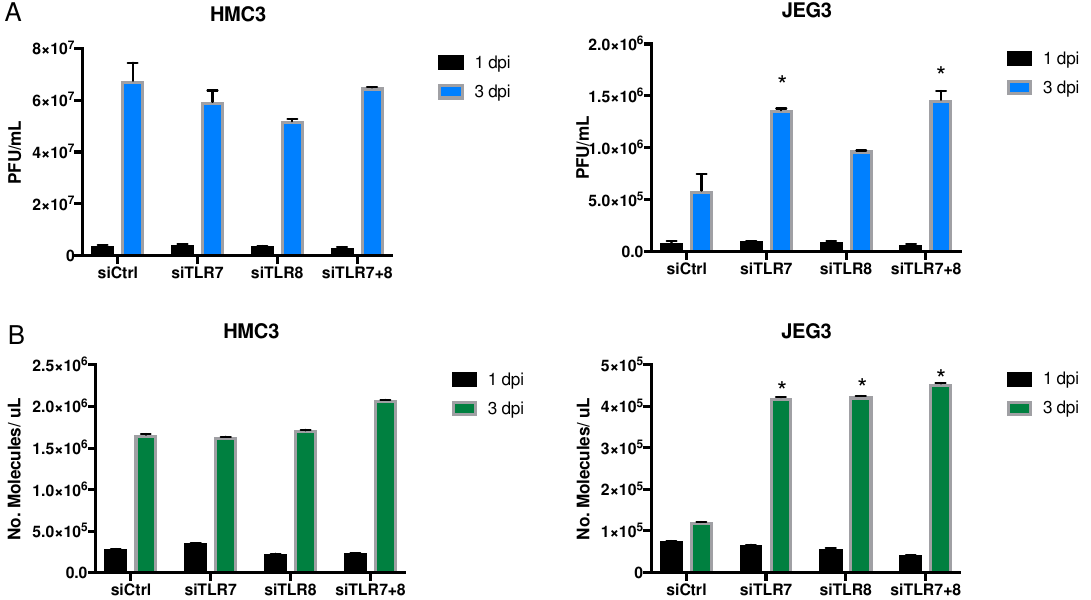
Figure 3. Viral and transcriptional effects of siRNAs targeting TLR7, TLR8, or TLR7 + TLR8 on ZIKV virus replication in different cell types over time. ( A ) Plaque-forming units (PFU) per mL of supernatant were measured to quantify infectious virus production at each time point in each cell type. ( B ) The number of ZIKV RNA molecules from the same samples was measured with RT-qPCR to quantify viral genome replication at both time points in each cell type (* p < 0.05). Error bars represent standard deviation.